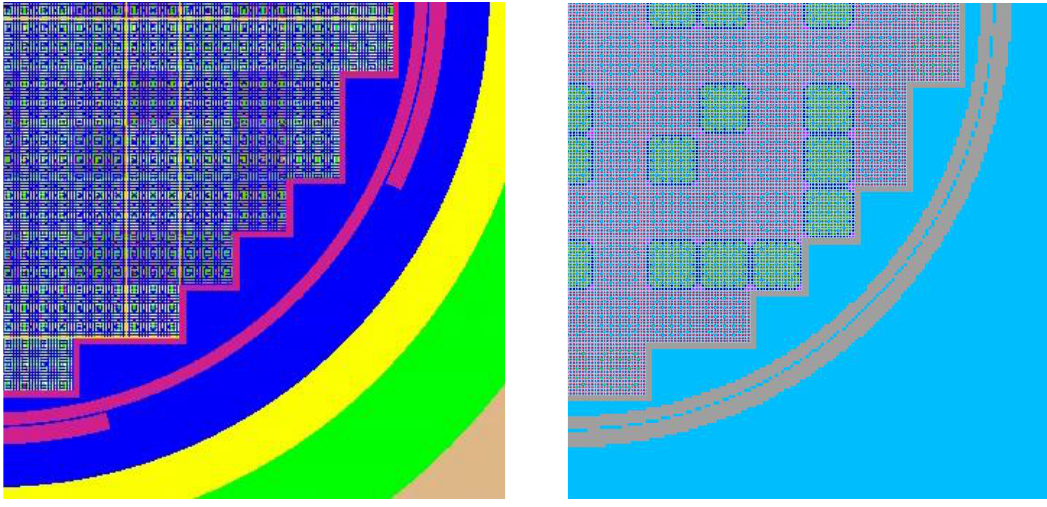
Figure 1. Reactor geometry modeling: MCNP (left) and CASMO5